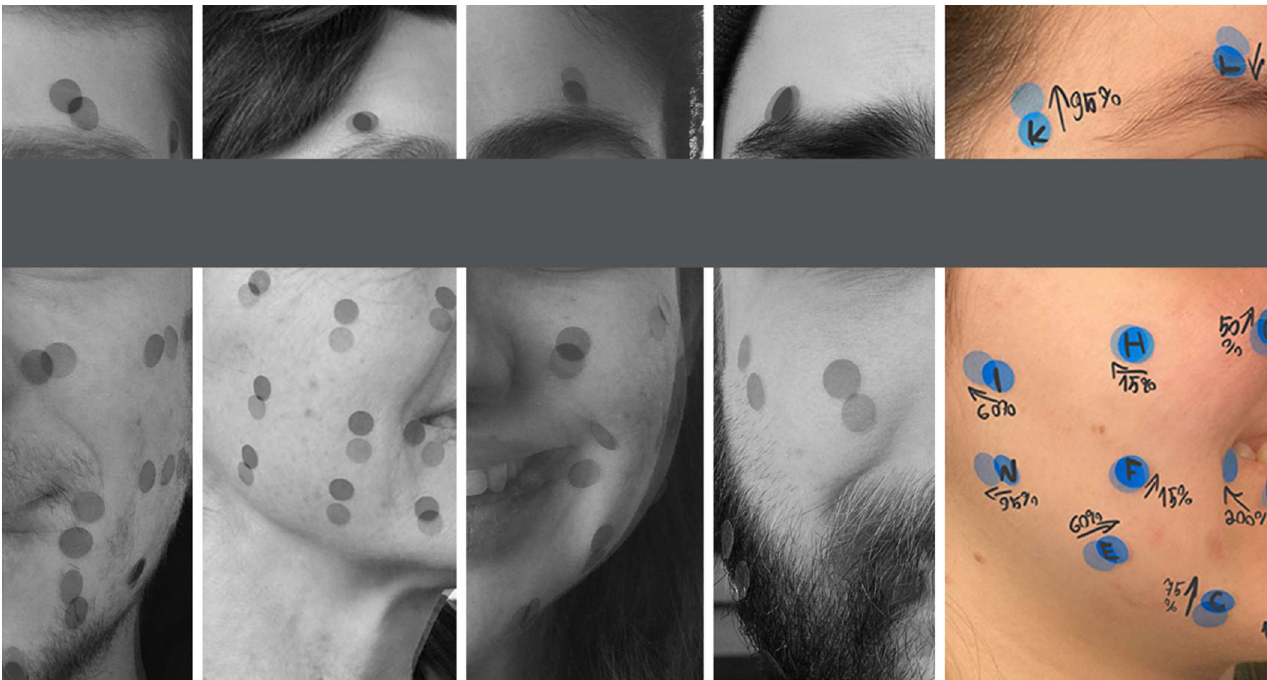
Figure 4. Selection of volunteers’ faces with superimposed nodes/dots.